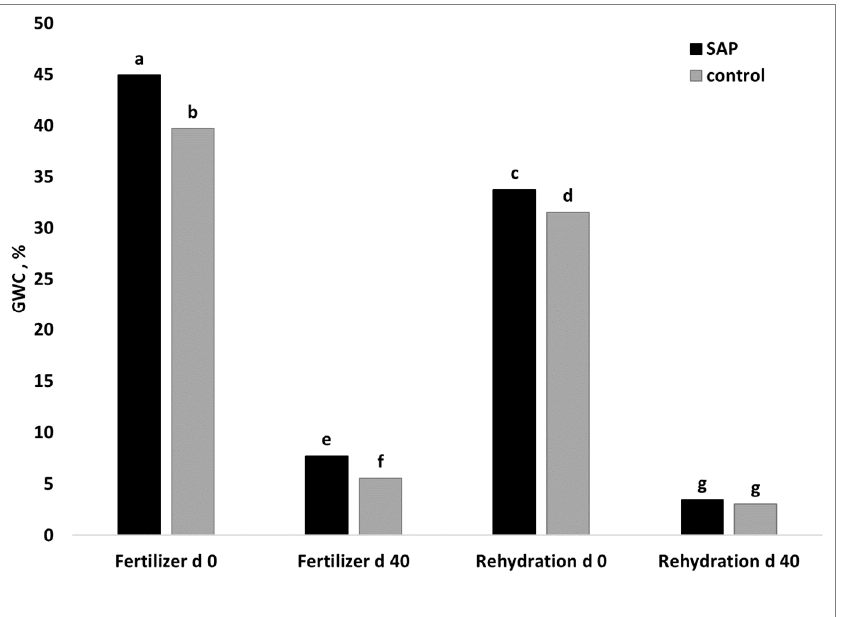
Figure 14. Comparison of gravimetric water content (GWC) as a function of superabsorbent polymer (SAP) application between original saturation for the fertilizer study and rehydration after dry-down period of 77 d. Data were averaged across species and fertilizer placement depth (0 or 8 cm). The SAP rate of 3000 kg ha − 1 was placed in a band at a depth of 8 cm directly below the seed. Following SAP treatment, the soil was saturated once and then dried down naturally over the time of the fertilizer study then rehydrated. Bars with different letters are statistically different from each other. p < 0.0001.